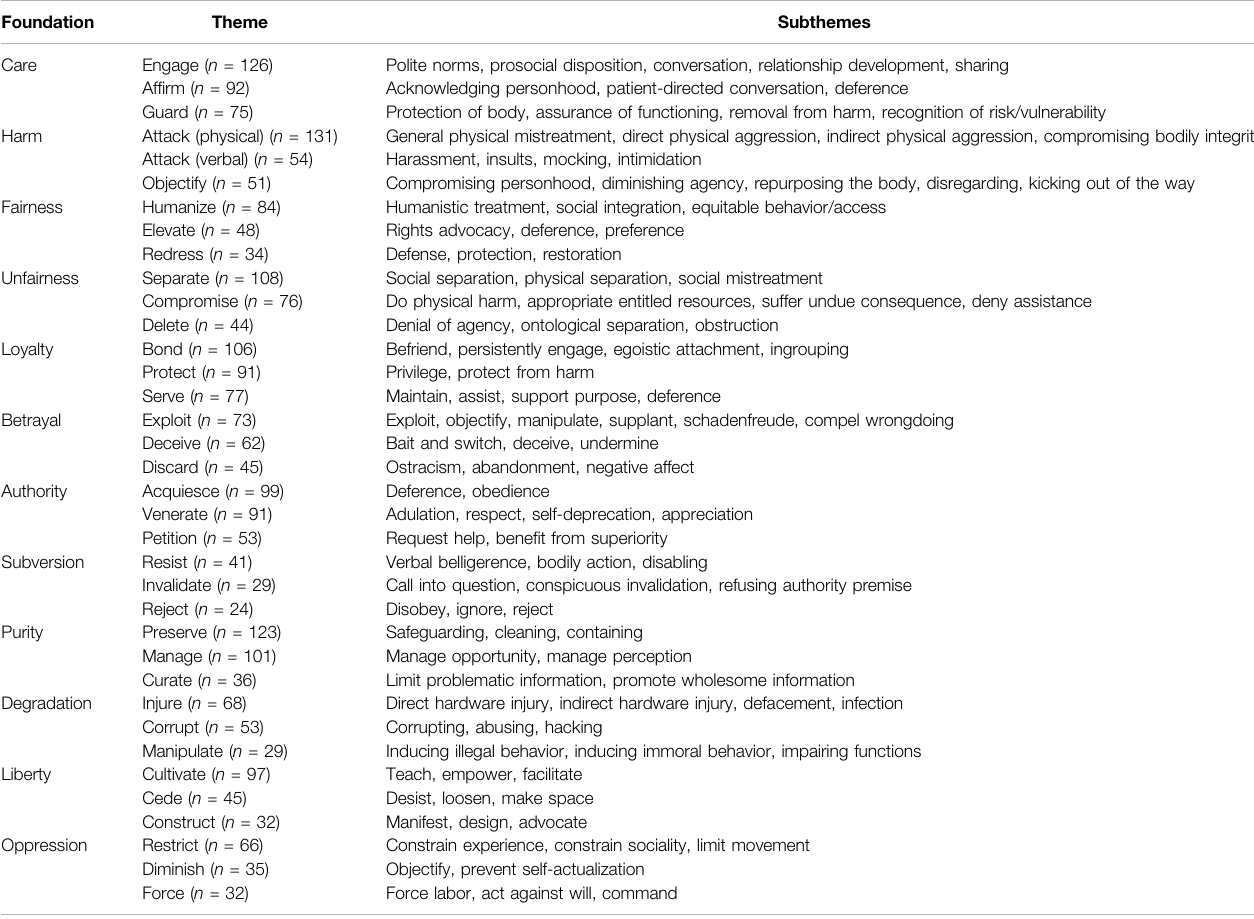
TABLE 2 | Hierarchical structure of moral-patiency themes and sub-themes, by foundation.